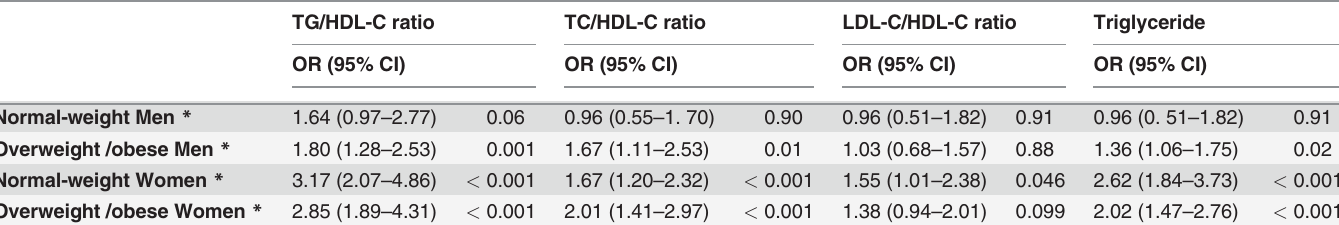
Table 2. Associations a of lipid pro fi les and triglycerides with insulin resistance in men and women categorized by BMI